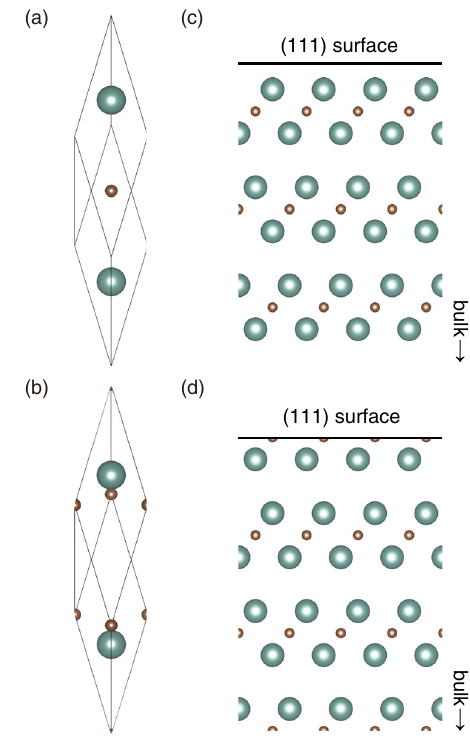
FIG. 8. Two choices of the unit cell and corresponding surface terminations of Y 2 C. (a),(b) Two choices of the unit cell of Y 2 C. The inversion centers are set at the centers of the unit cell in both cases. The choice in (a) is the one used in our calculation of the parity eigenvalues in the present paper, and the inversion center is at the carbon atom. (b) shows another choice of the unit cell which is shifted by half of the lattice constant from (a) along the [111] direction. (c) and (d) show the surface terminations of the (111) surface, which correspond to the unit cell choices (a) and (b), respectively. We note that, in (d), the carbon atoms are cut in half, which is